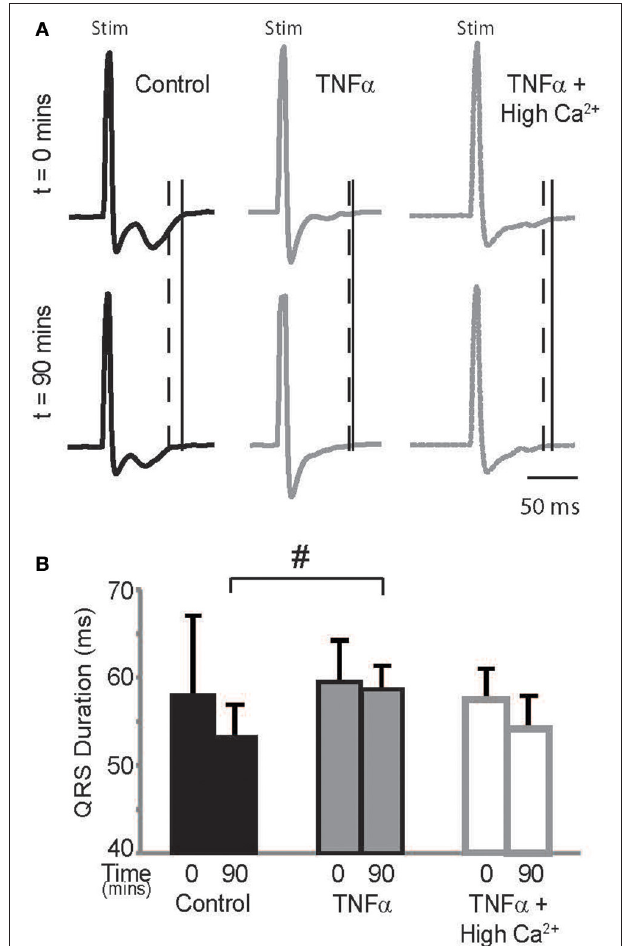
FIGURE 5 | ECG (A) Paced QRS complexes from volume-conducted ECG traces recorded from control, TNF α and TNF α + high calcium perfused hearts. Solid vertical lines indicate end of QRS of ECGs from t = 0 mins and dashed vertical lines indicate end of QRS and T waves of ECGs from t = 90mins. “Stim” indicates stimulus artifacts. (B) Summary of QRS duration. # indicates p < 0.05 relative to control